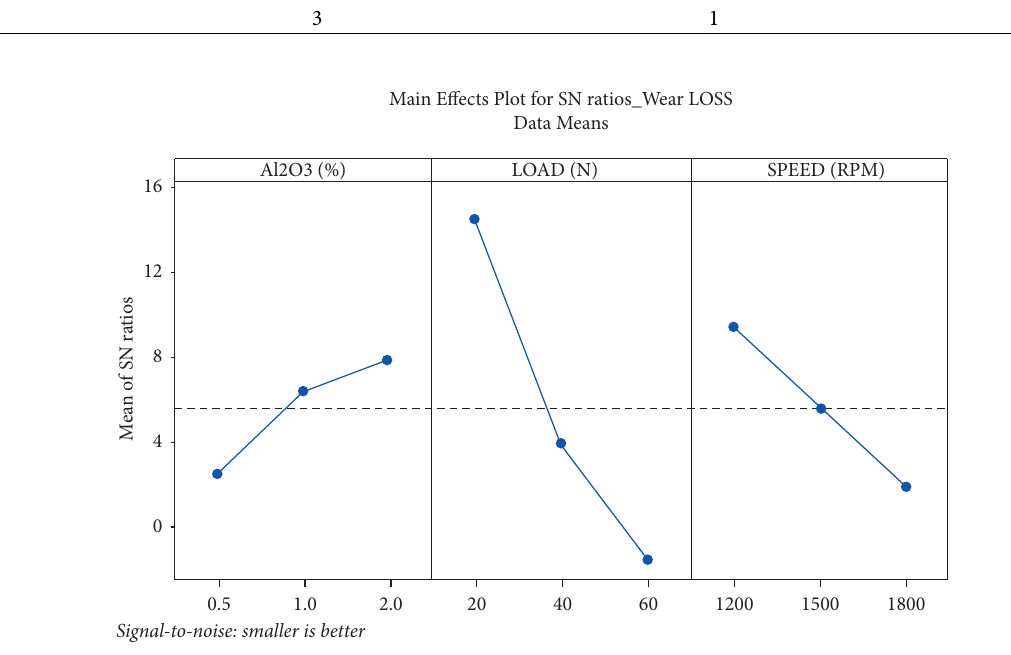
Figure 15: Main efect plot for SN ratios for wear